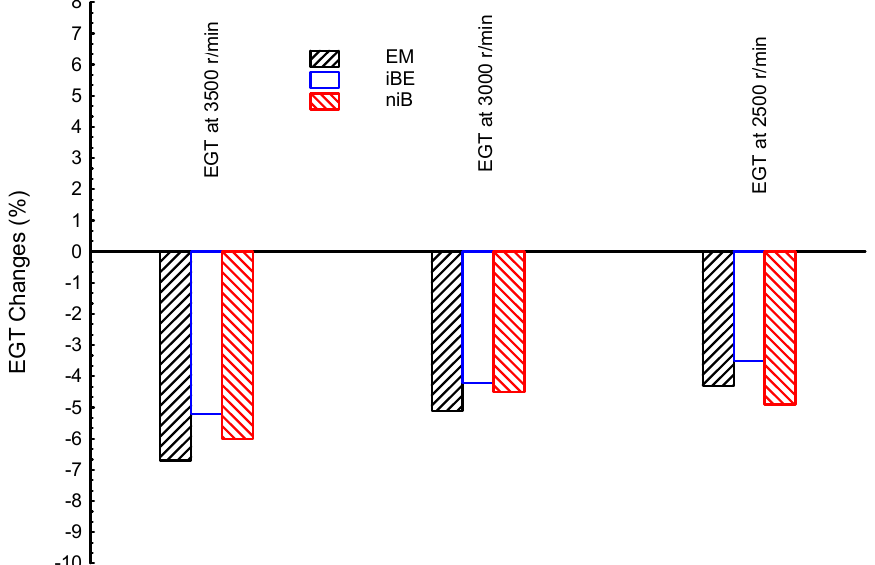
Figure 1. Exhaust gas temperature (EGT) at three different engine speeds (3500, 3000, and 2500 r/min) for ternary blended fuels of bio-ethanol–bio-methanol–gasoline (EM), iso-butanol–bio-ethanol– gasoline (iBE), and n-butanol–iso-butanol–gasoline (niB); gasoline is the reference